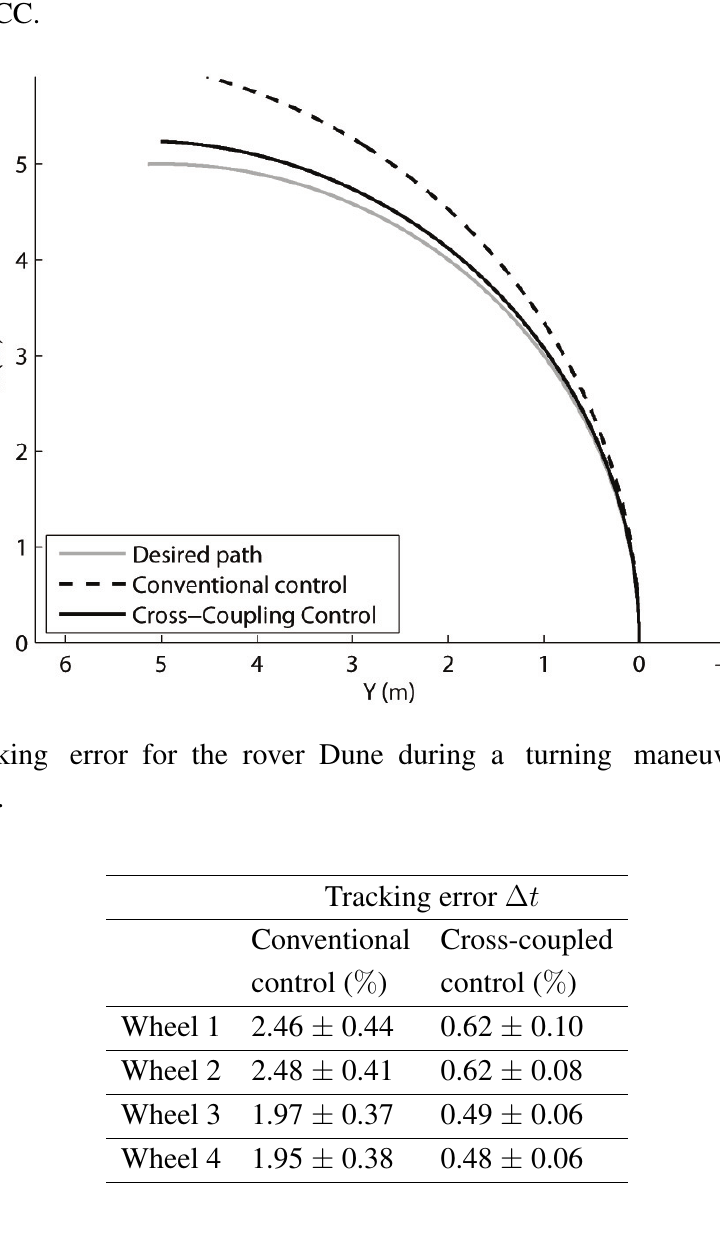
Figure 10. Comparison of Cross-coupled Control with Conventional Control during turning motion on agricultural terrain (V = 5 cm/s, ω = 0.05 rad/s). Grey solid line: Desired path. Black solid line: Encoder-derived path using the CCC. Black dashed line: Encoder-derived path using the CC.